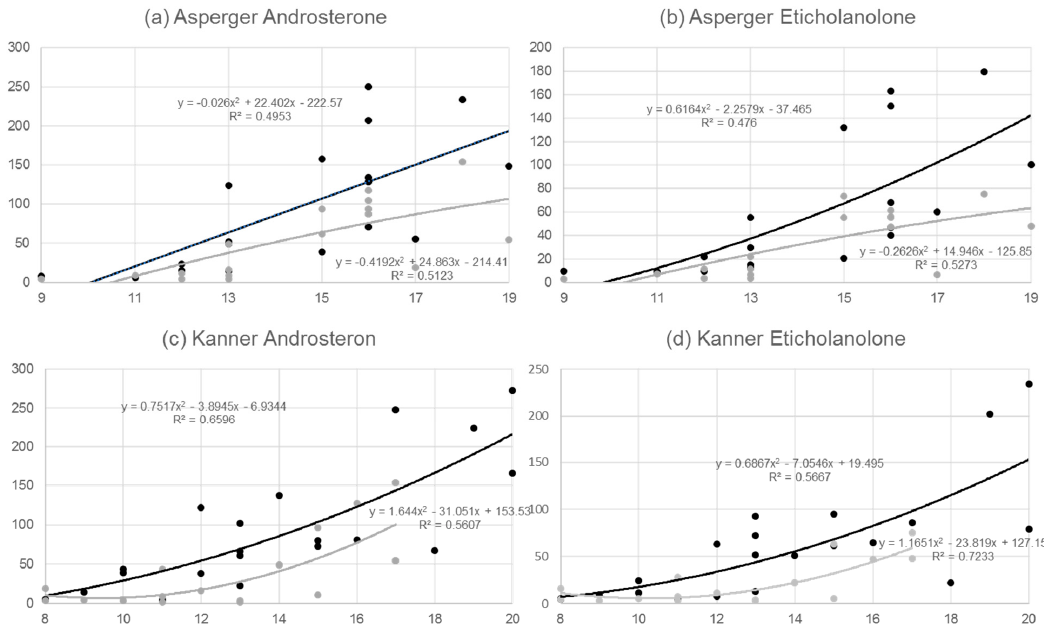
Figure 1. ( a ) Correlative relationship between age and androsterone (ratio of androsterone (mmol / L) to urine creatinine ( µ mol / L)) for n = 20 boys with Asperger syndrome (black line) and for n = 20 pairwise matched controls (grey line). ( b ) Correlative relationship between age and etiocholanolone (ratio of eticholanolone (mmol / L) to urine creatinine ( µ mol / L)) for n = 20 boys with Asperger syndrome (black line) and for n = 20 pairwise matched controls (grey line). ( c ) Correlative relationship between age and androsterone (ratio of androsterone (mmol / L) to urine creatinine ( µ mol / L)) for n = 21 boys with Kanner syndrome (black line) and n = 21 pairwise matched controls (grey line). ( d ) Correlative relationship between age and etiocholanolone (ratio of androsterone (mmol / L) to urine creatinine ( µ mol / L)) for n = 21 boys with Kanner syndrome (black line) and n = 21 pairwise matched controls (grey line). Table 3. Correlation matrices depicting the relationship between the significantly di ff erent hormones in ( a ) Asperger n = 20 ( b ) Kanner n = 21 ( c ) Asperger controls n = 20 ( d ) Kanner controls n = 21. Abbreviations: Andro = Androsterone, Etio = Etiocholanolone, PT = Progesterone, THE = Tetrahydrocortisone, THF = Tetrahydrocortisol, 5aTHF = 5a-Tetrahydrocortisol. Dark green correlation between 0.5 < correlation < 1, light green 0 < correlation < 0.5, red correlation is negative. ANDRO ETIO PT